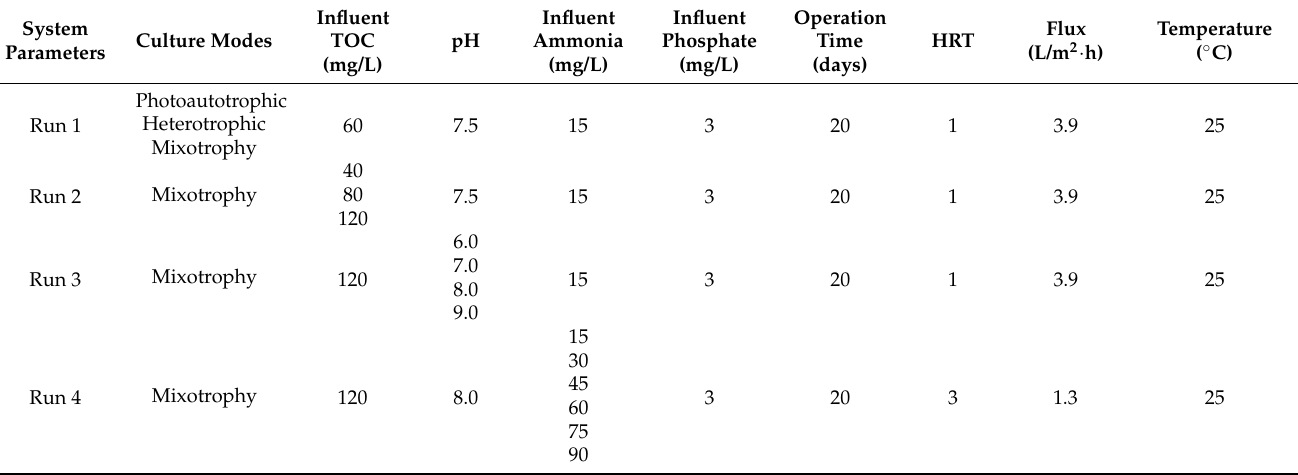
Table 1. Experimental arrangement for studying the treatment efficiency of and biomass production of the microalgae membrane bioreactor under different operating